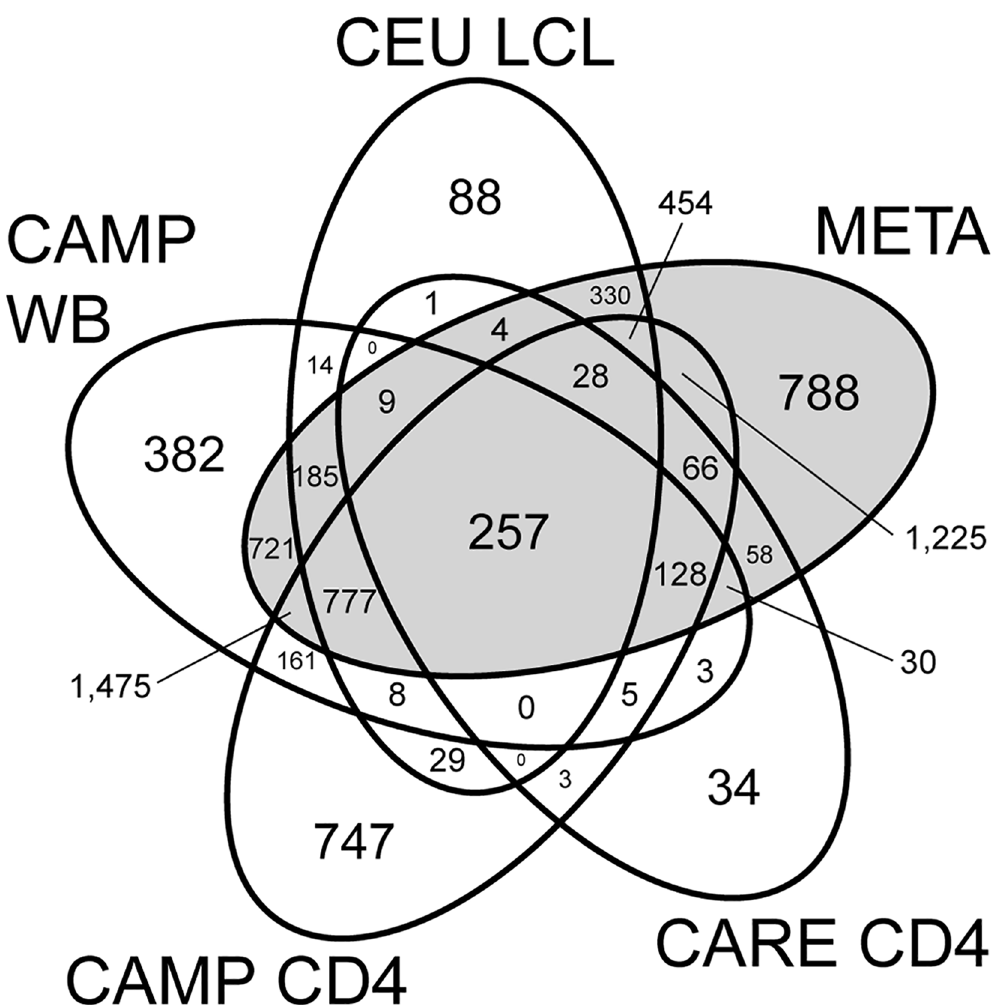
Fig 1. Venn diagram of overlaps of eQTL genes identified in specific individual cohorts and through meta-analysis. Numbers represent counts of genes with at least one significant eQTL SNP (FDR < 5%) in each of the four study cohorts ( “ CAMP WB ” , “ CAMP CD4 ” , “ CEU LCL ” , and “ CARE CD4 ” in white ellipses) and in their combined meta-analysis ( “ META ” in gray ellipse). Total counts for each group are also summarized in Table 1